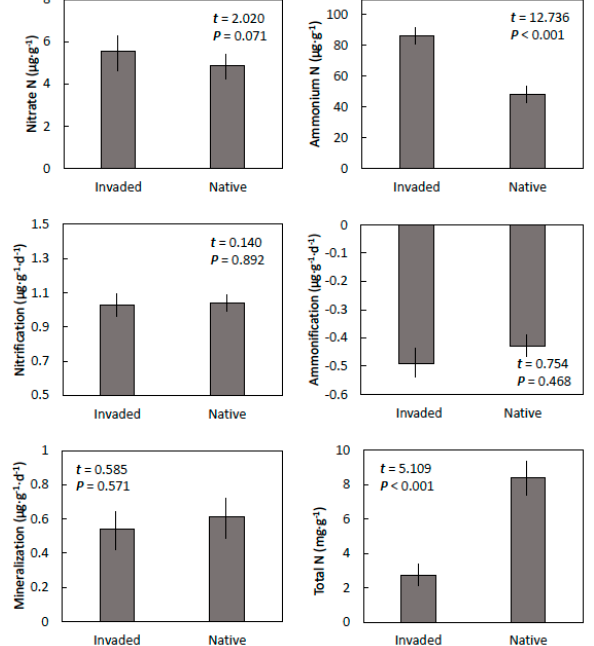
Figure 4. The nitrogen properties of Guam cobbly clay soils within invaded mature stands of. Spathodea campanulata and in adjacent native forest in central Guam. Means ± SE, n = 6.